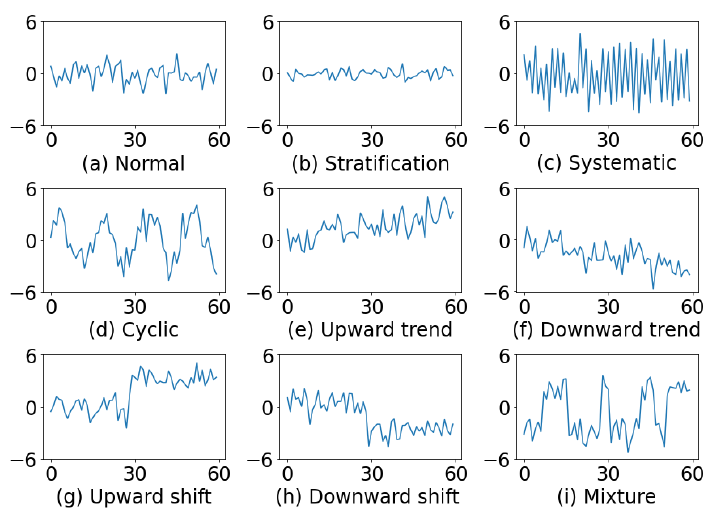
Figure 1. Typical examples of control chart patterns.